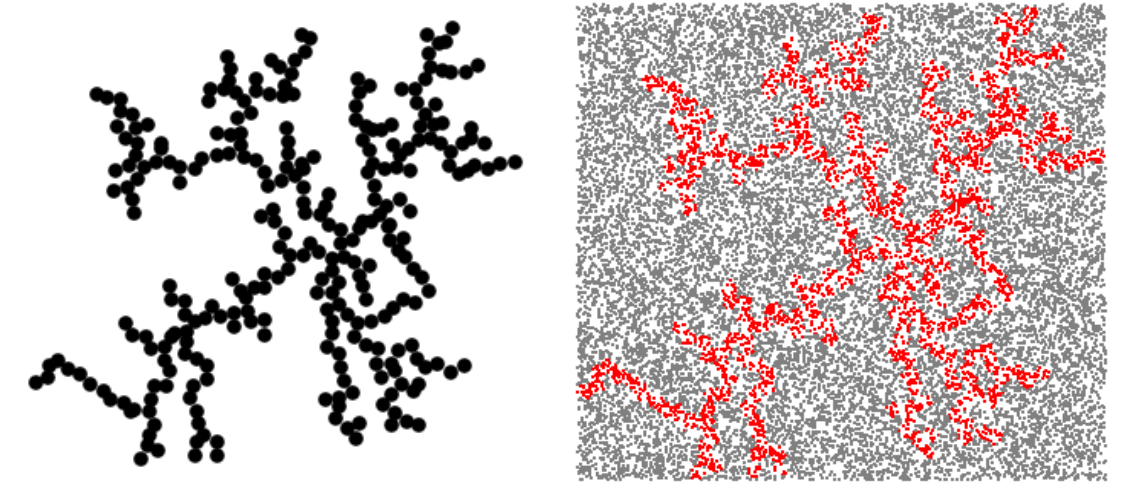
Figure 3. (Color online) Left-side : Representation of a 2D DLA with 284 disks as basic units. Right-side : Monte Carlos simulation of DLA: Red points are inside the DLA, grey points are